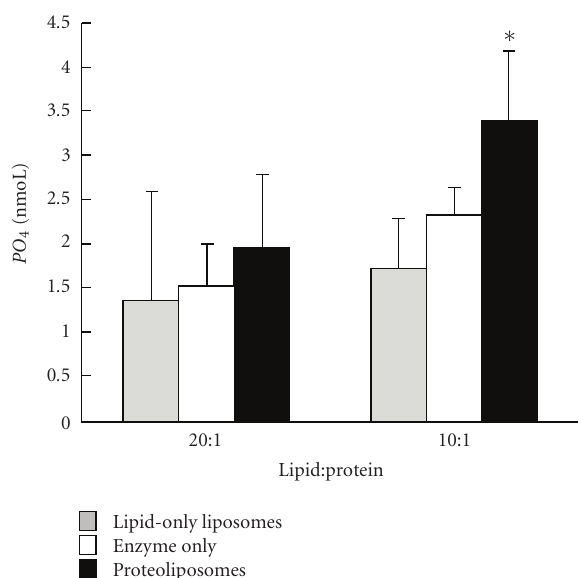
Figure 4: Mean phosphate (PO 4 ) detected (nmoL ± SD) in liposomes (lipid-only liposomes), Na + K + -ATPase alone (enzyme- only), and proteoliposomes (liposomes containing ATPase) made by filtration with a lipid:protein ratio of 20:1 ( n = 4) or 10:1 ( n = 4) after 60 minutes of incubation. Liposomes and prote- oliposomes contained 0.5 μ g lipid/ μ l prior to vesicle production, while proteoliposomes and enzyme-only contained 0.025 μ g Na + K + -ATPase/ μ l for 20 :1 and 0.05 μ g Na + K + -ATPase/ μ l for 10 :1. PO 4 in each well was detected by reading colour intensity at 750nm. Significant di ff erences within lipid :protein are marked by ∗ .